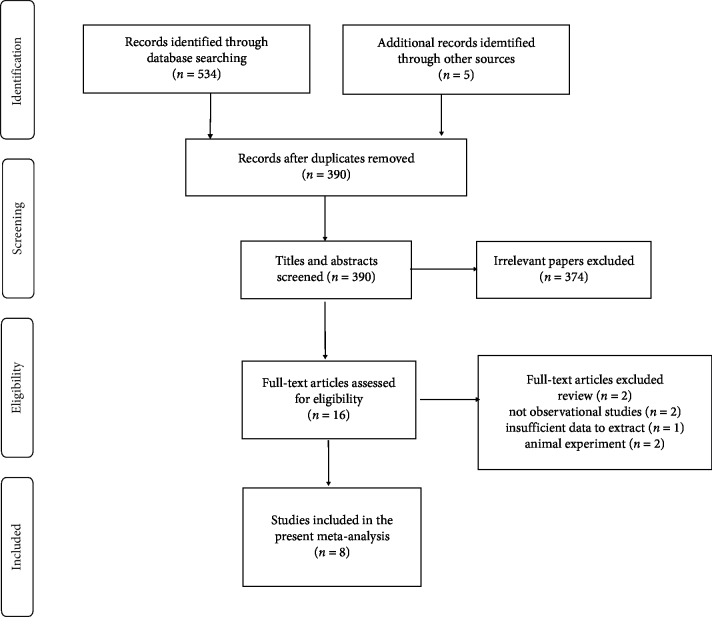
Study selection flow diagram.